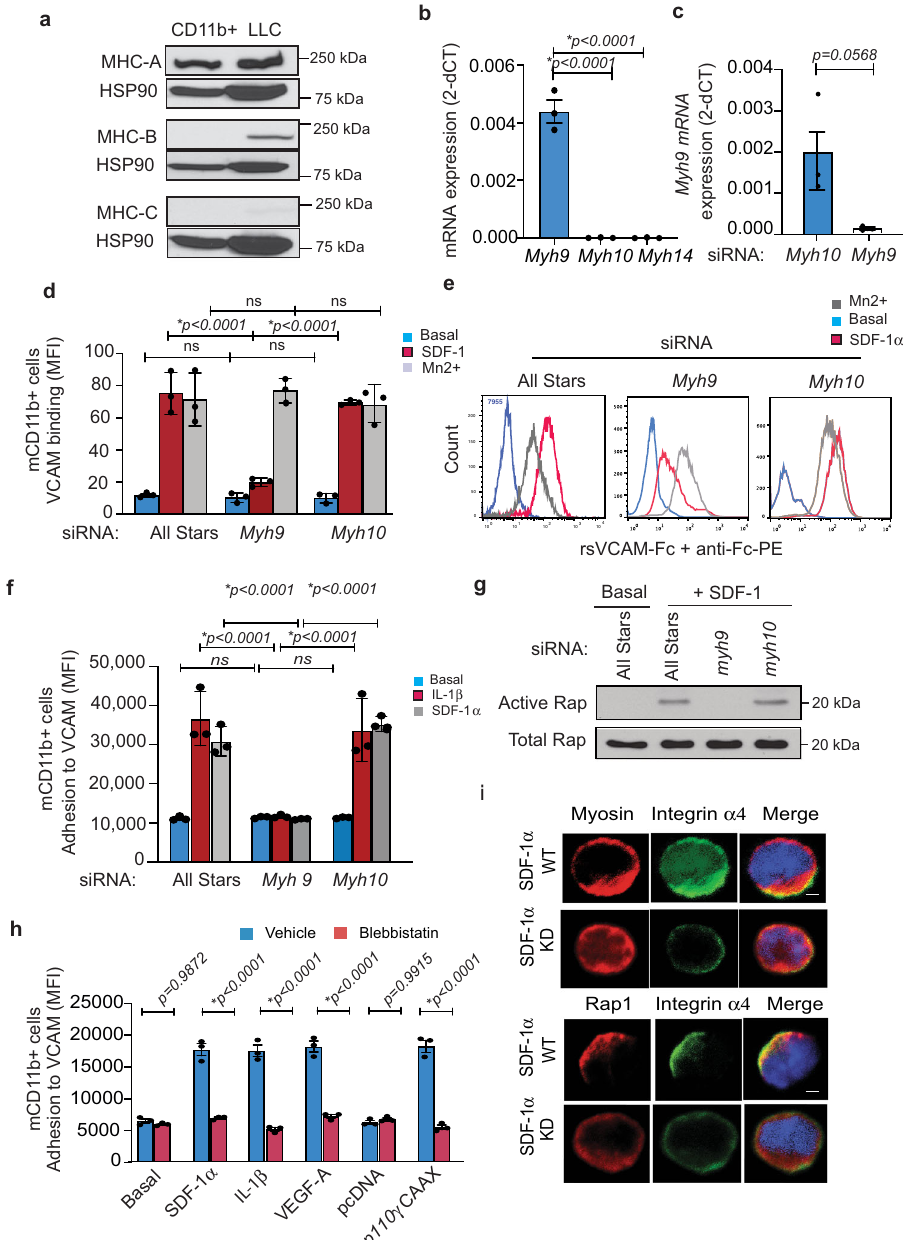
Fig. 5 MLCK and myosin in myeloid cells. a Immunoblotting of primary murine myeloid cells (CD11b + ) and Lewis lung carcinoma (LLC) cells with anti- myosin heavy chain A, B, and C or HSP90 antibodies. b RT-PCR analysis of mRNA expression of Myh9 , Myh10 , and Myh14 in myeloid cells ( n = 3, * p < 0.0001 Myh9 vs Myh10 or Myh14 ). c Effect of Myh9 and Myh10 siRNA on Myh9 expression ( n = 3, p = 0.0568). d , e Quanti fi cation ( d ) and FACS pro fi les ( e ) of VCAM-Fc binding to All Stars, Myh9 and Myh10 siRNA-transfected myeloid cells ( n = 3). *p < 0.0001 for SDF-1 stimulated, p > 0.9999 for EBM stimulated, and p > 0.9000 for Mn2 + stimulated Myh9 vs All Stars and vs Myh10 siRNA-transfected cells. f Cell adhesion to VCAM of Myh9 and Myh10 siRNA-transfected myeloid cells ( n = 3). *p < 0.0001 for SDF-1 and IL-1 stimulated Myh9 vs All Stars and Myh10 siRNA. g Effect of Myh9 and Myh10 siRNA on Rap1 activation by SDF-1 α in myeloid cells. h Cytokine and p110 γ CAAX stimulation of myeloid cell adhesion to VCAM-1 in the presence of vehicle or the myosin ATPase inhibitor blebbistatin ( n = 3). p = 0.9812 vehicle vs blebbistatin basal medium, *p < 0.0001 vehicle vs blebbistatin for SDF-1 α , IL1 β , VEGF, p110 γ CAAX, and p = 0.9915 vehicle vs blebbistatin for pcDNA. i Immuno fl uorescence detection of integrin α 4 (green) and myosin or Rap1 (red) in SDF1-bead-stimulated Mlck210 − / − myeloid cells that were transfected with WT or kinase-dead Mlck210 cDNA. Nuclei were detected with Dapi (blue). Scale bar = 5 µ m. All replicates are biologically independent samples. Data are presented as mean values ± SEM. Signi fi cance determined by one-way Anova with Tukey ’ s multiple comparisons for panels b , d , f , and by unpaired t -test for panels c , h . Experiments were performed twice. Source data are provided with this article as a Source Data fi